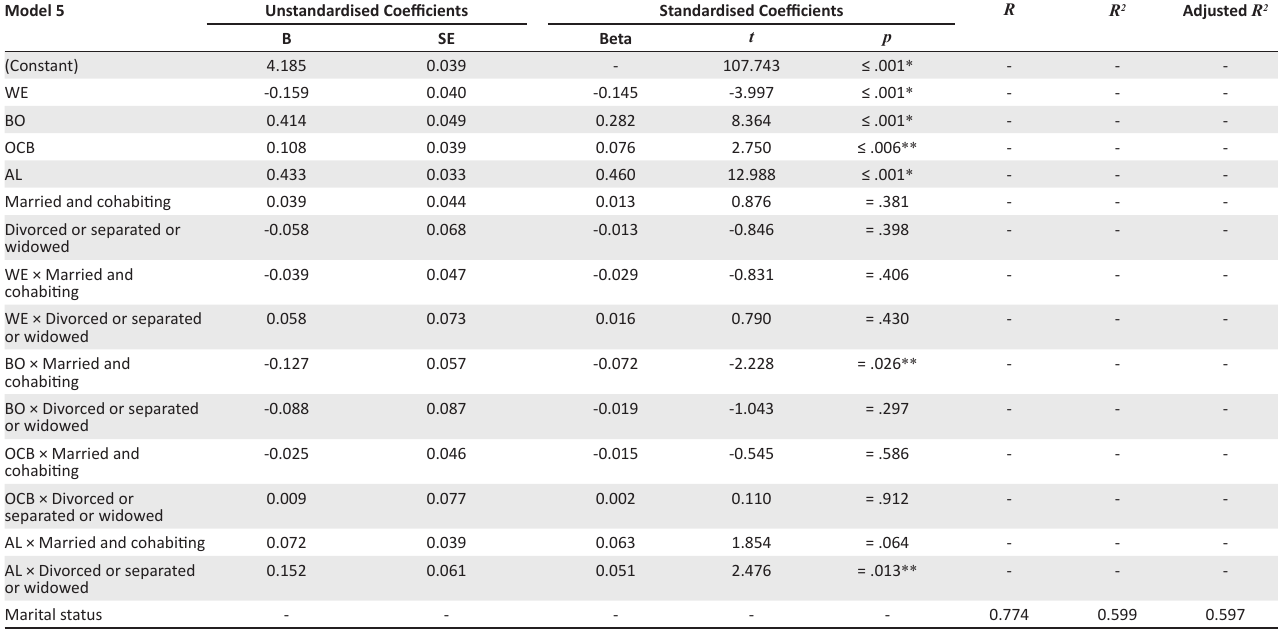
TABLE 5: Moderated multiple regression in terms of marital